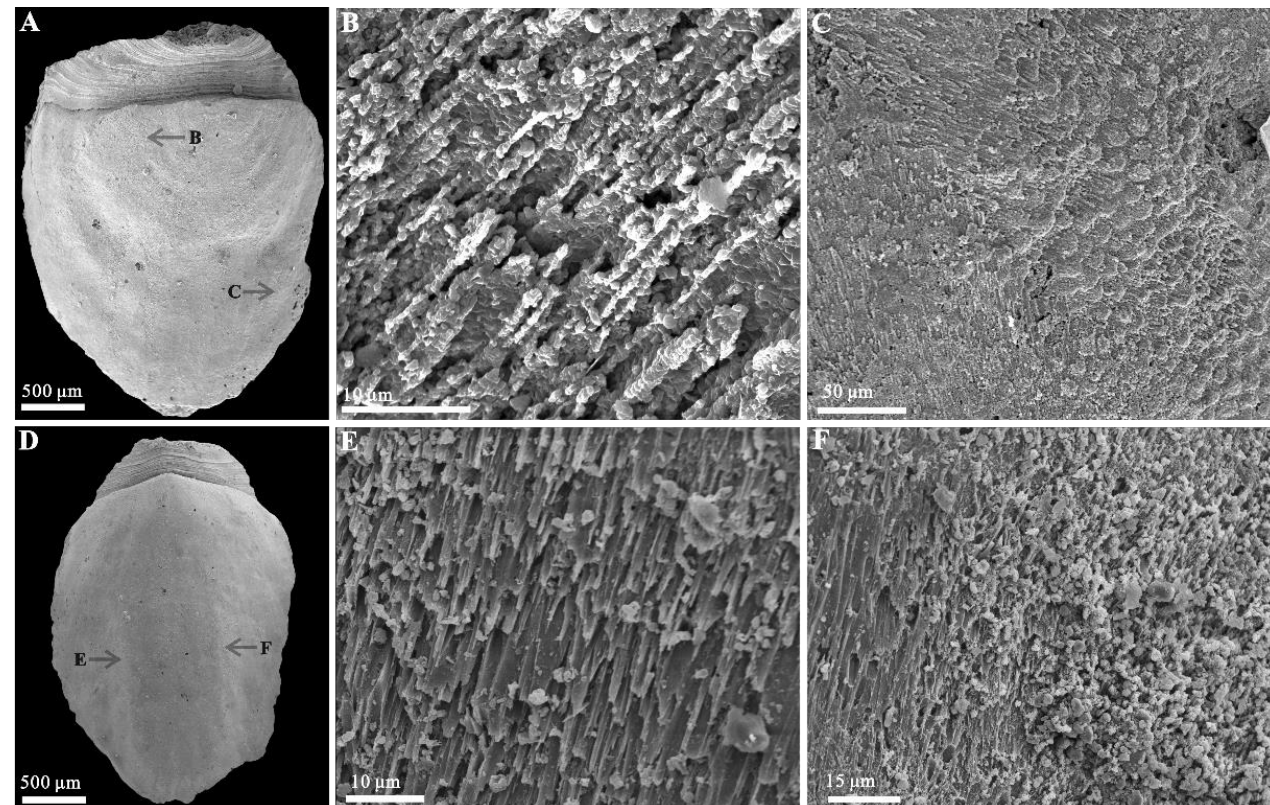
Figure 5. Lamello-fibrillar structure of Eohalobia sclerites. ( A – C , D – F ) Internal molds, CUBar47 – 28, CUBar132 – 2, respectively. ( B , E ) Magnification of ( A , D ), respectively, showing the shape and size of fibers, which are horizontal and parallel to each other. ( C , F ) Magnification of ( A , D ), respectively, showing the fibers and convex polygons structure co-occurring on the surface of internal molds and gradually fused to lamellar units. Arrows show position of enlarged areas.